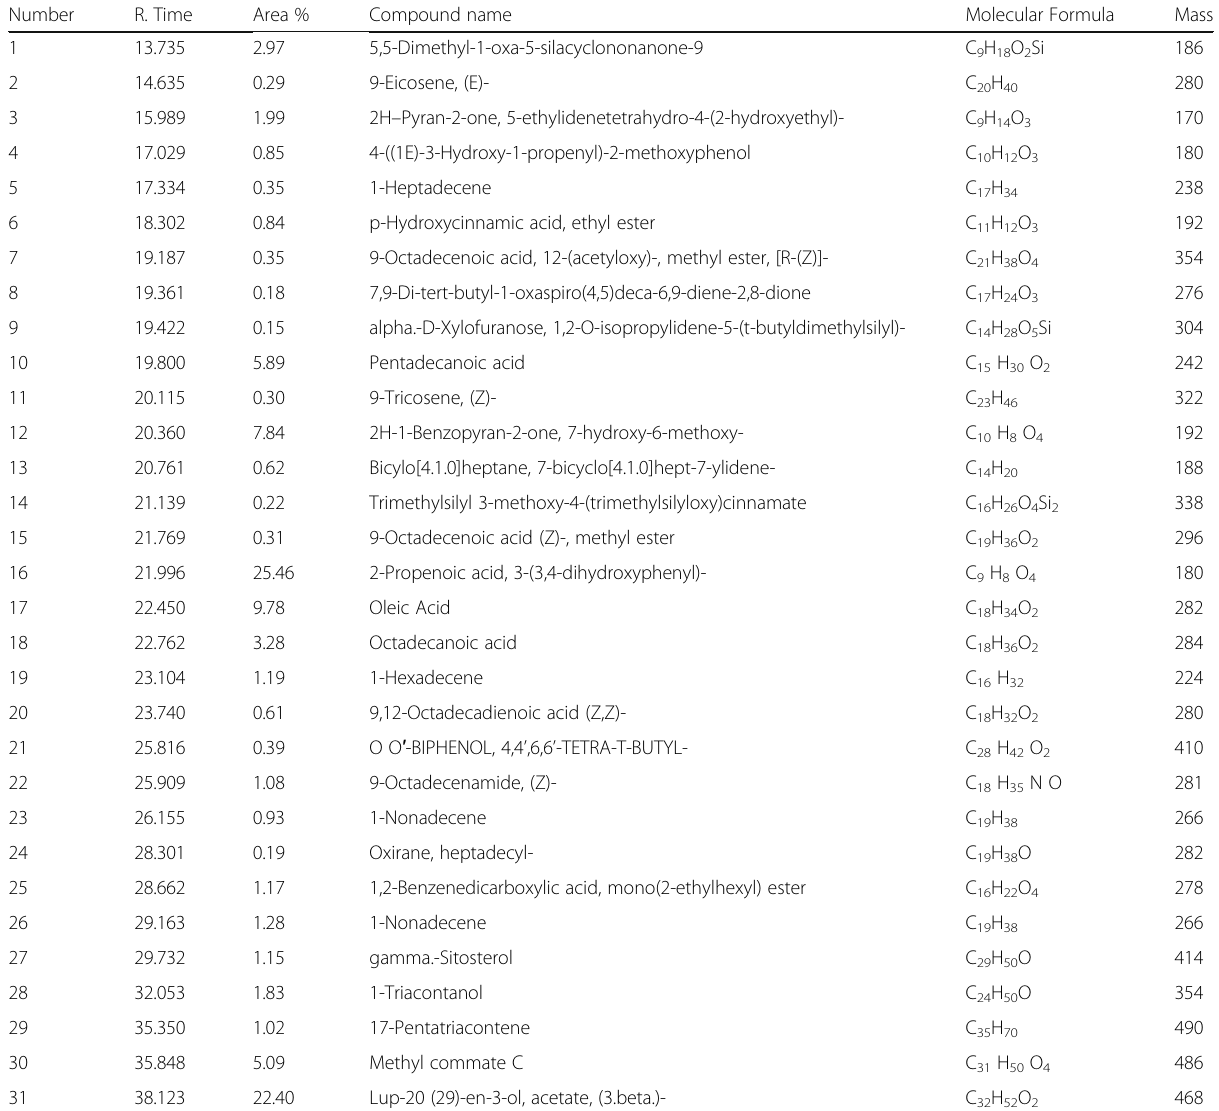
Table 5 GC-MS spectral analysis of chloroform fraction of S. latifolius bark Number R.